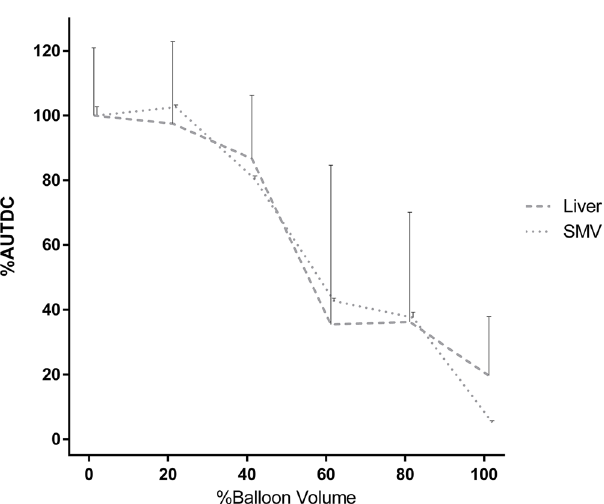
Figure 3. Time-density curve of the superior mesenteric vein under a regulated occlusion volume in partial resuscitative endovascular balloon occlusion of the aorta. The peak density of the time-density curve gradually decreased, and the time to peak was increasingly delayed as balloon volume increased.